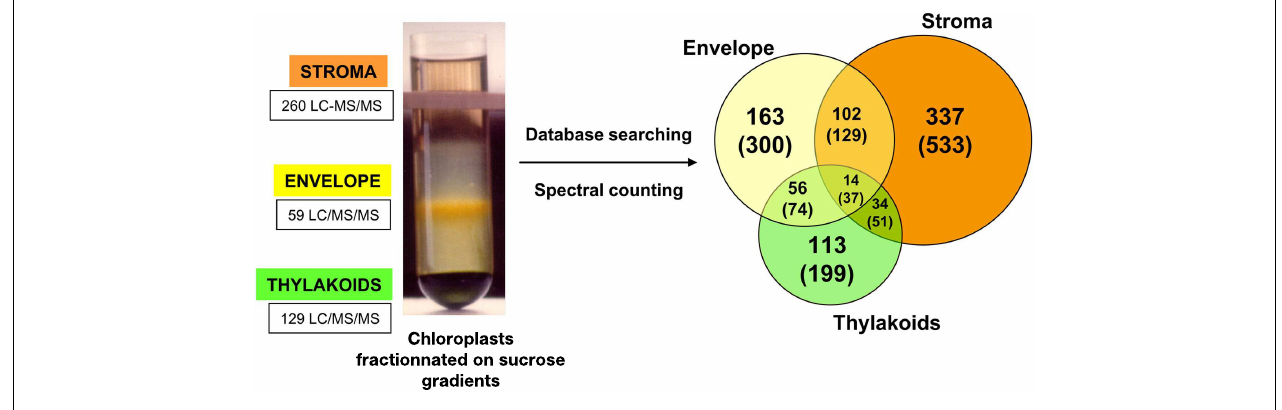
on Percoll-purified chloroplasts. After centrifugation, the envelope membrane and the thylakoids are present as a yellow band at the 0.93/0.6M interface and as a dark green band at the bottom of the tube, respectively.The soluble fraction containing the stroma remains on top of this gradient (see, Salvi et al.,